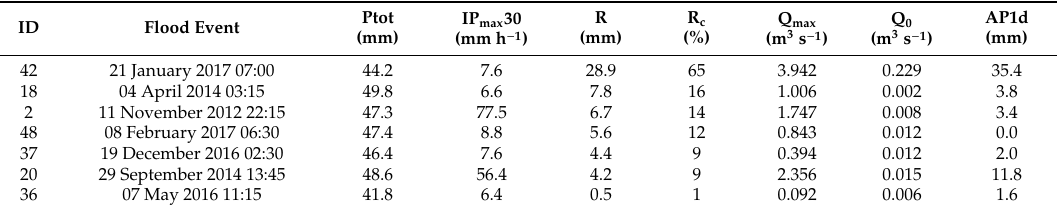
Table A4. Main characteristics of the selected events for non-linearity analysis in Es Fangar Creek.